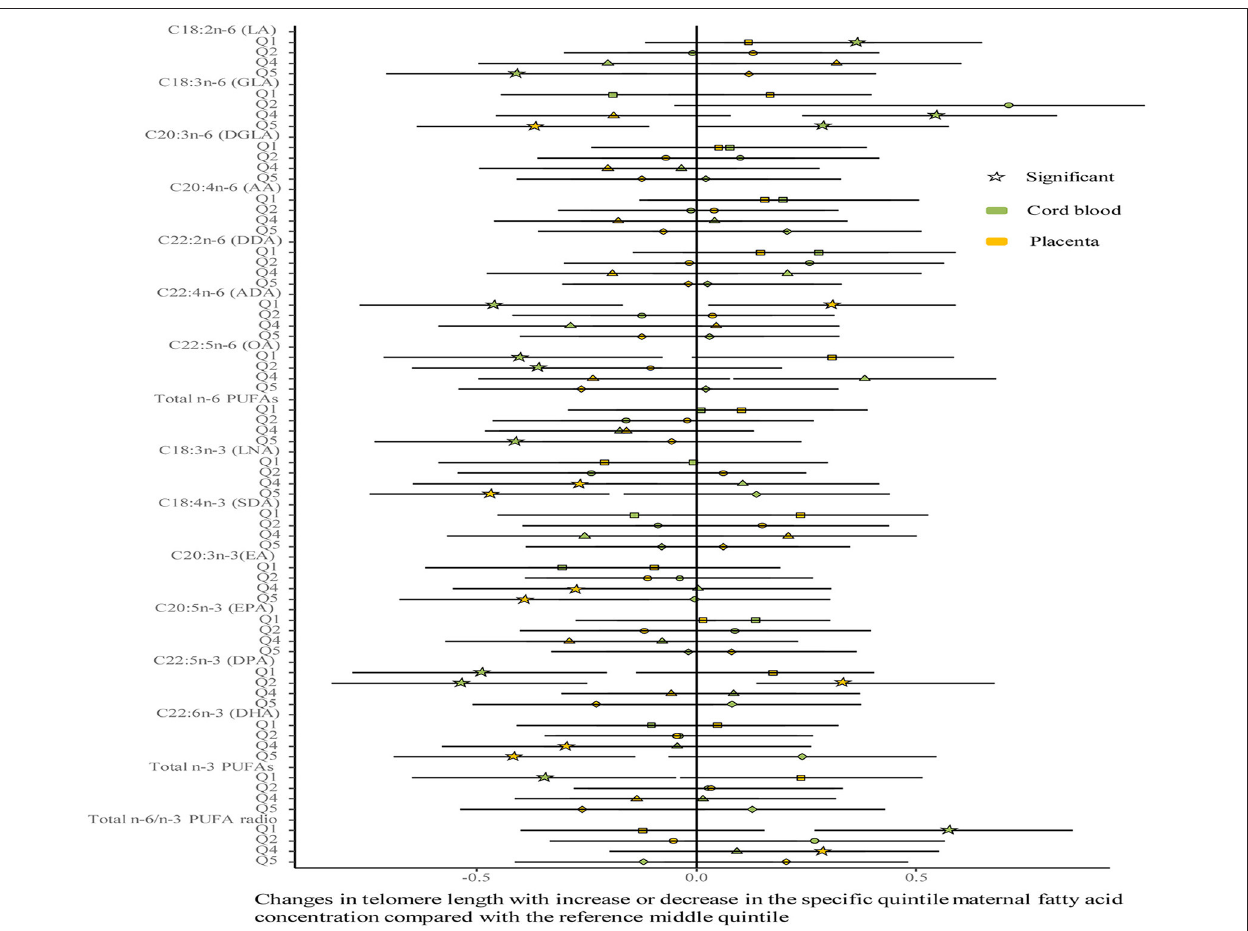
FIGURE 3 | Analysis of differences in the associations of maternal erythrocyte fatty acids and TL between the cord blood and the placenta by categorical multivariate regression. The categorical model is used to include quintiles as categorical concentrations of fatty acids. Quintiles are performed as a measure of maternal fatty acids concentration with the middle quintile as a reference (see Supplementary Table 2 ) to determine the potential nonlinearity of the association, with the quintiles as independent variables and TL as dependent variables. β -coefficients and 95% CI are adjusted for gestational age at birth, infant sex, birth weight and length, and maternal age, maternal prepregnancy BMI, and gestational weight gain, and paternal age and BMI, and represent differences between TL in the specific quintile and that in the reference middle quintile. Star: significant; color green: the cord blood; color yellow: the